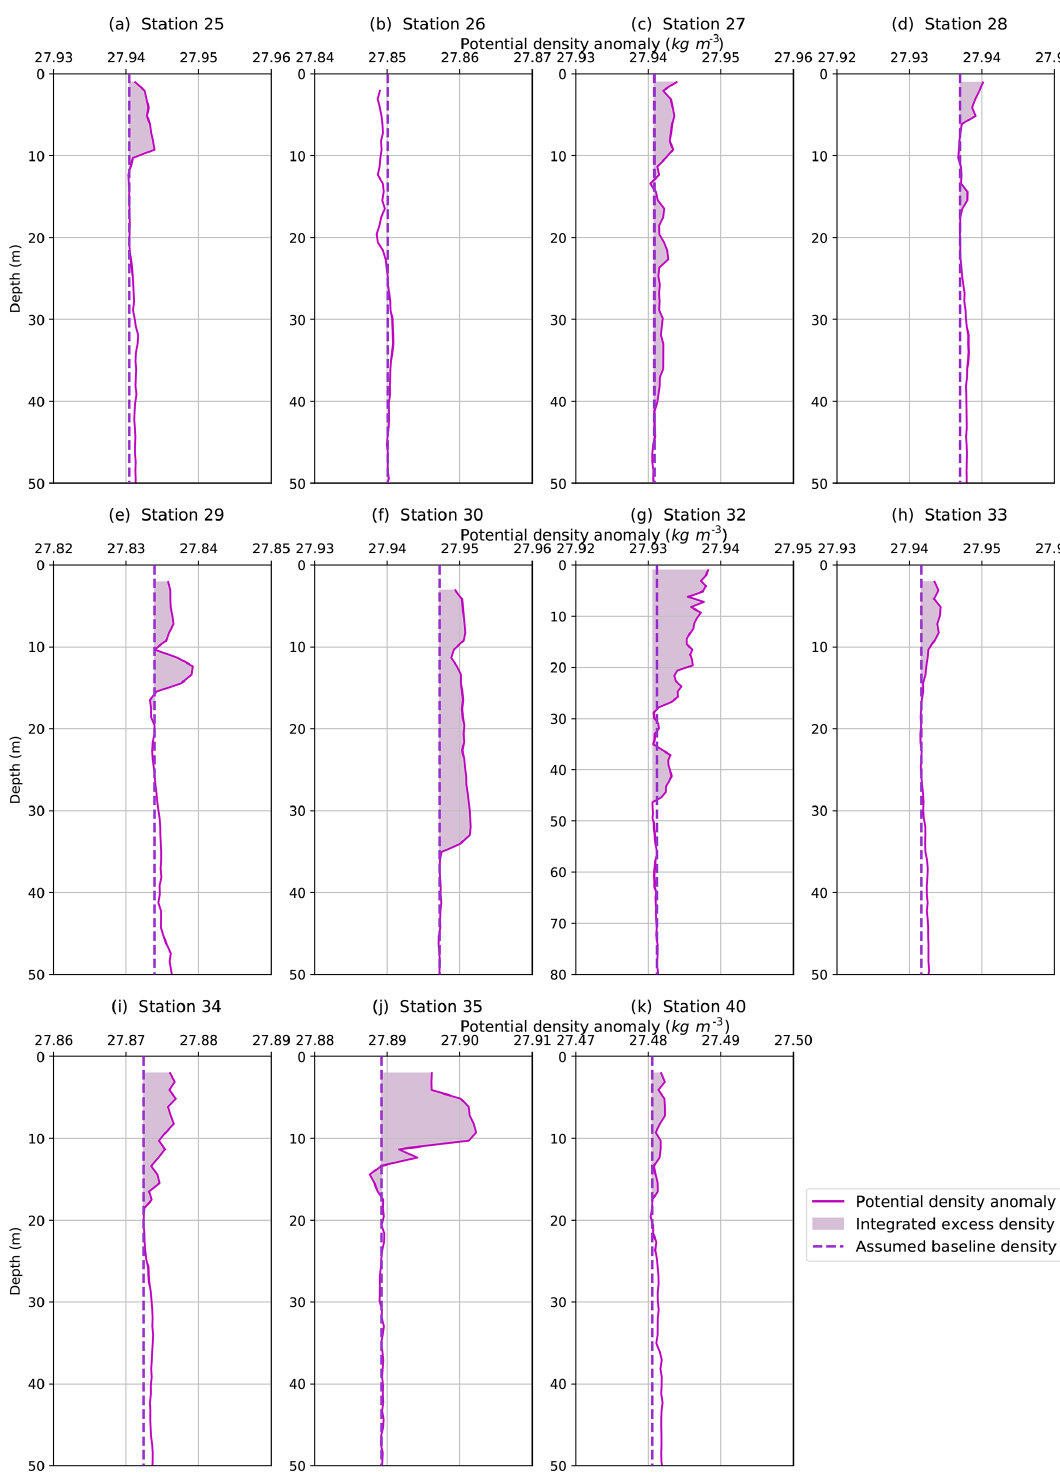
Figure 8. Potential density anomalies for all 11 stations with evidence of active frazil ice formation. The integrated excess density and assumed baseline density are depicted to highlight the instability. Note that Station 26 (b) does not present a density anomaly because it does not have a salinity anomaly. In the absence of excess salinity, the temperature anomaly instead created an area of less dense water (i.e., a stable